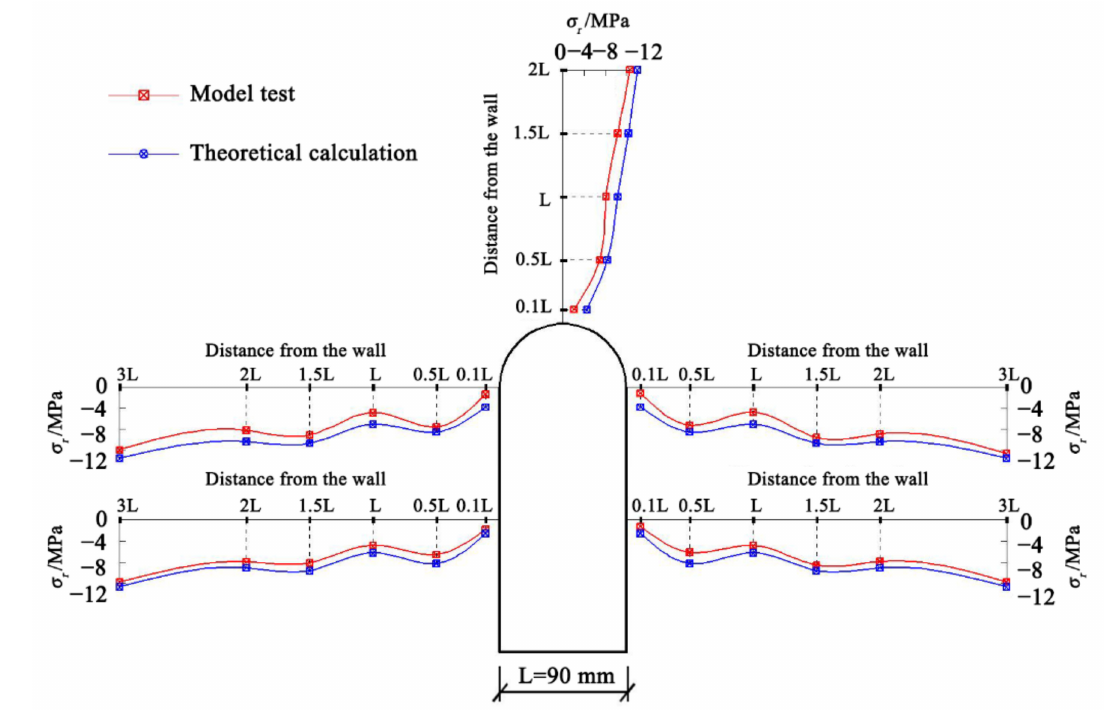
Figure 11. Variation of the radial stress around the cavern.